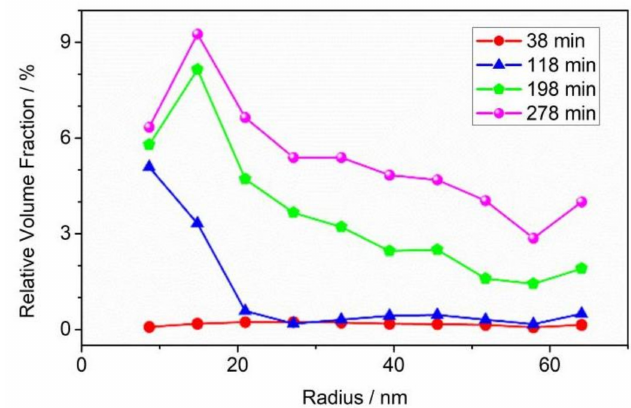
Figure 9. Pore size distribution of CL-20 as a function of storage time when the temperature is fixed at 200 ◦